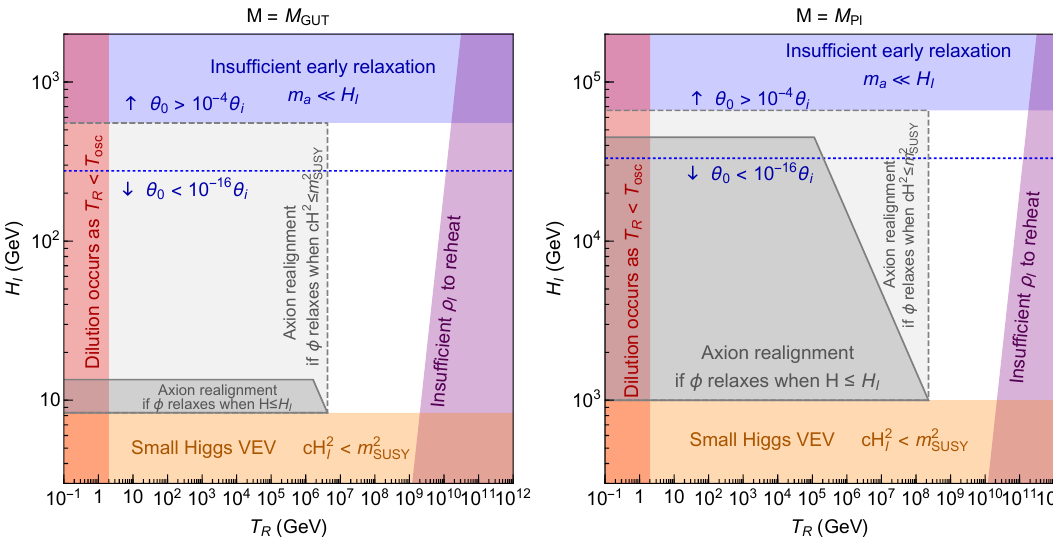
Figure 2 . Parameter space for the in(cid:13)ationary Hubble scale H I and reheat temperature T R given f a = 3 (cid:2) 10 9 GeV, m ~ g = m SUSY = TeV, B(cid:22) = m 2 = tan (cid:12) , tan (cid:12) = 50, N e = 60, and (cid:30) i = M . SUSY The left (right) panel is for the cuto(cid:11) scale M = M GUT ( M Pl ) respectively. (cid:30) continues to be trapped around M . This means the radial and angular directions of the Higgs (cid:12)elds do not oscillate until the Hubble induced terms become subdominant to the MSSM soft terms of the corresponding mode as the in(cid:13)aton energy density redshifts and/or